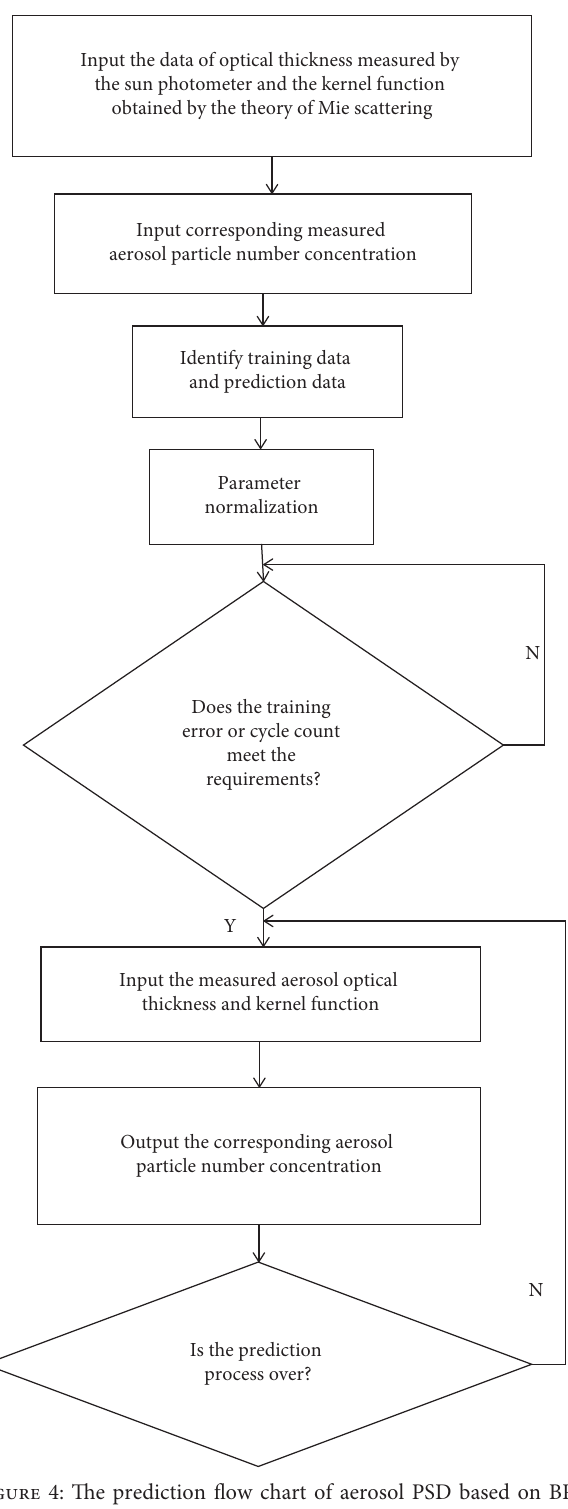
Figure 4: The prediction flow chart of aerosol PSD based on BP neural network.